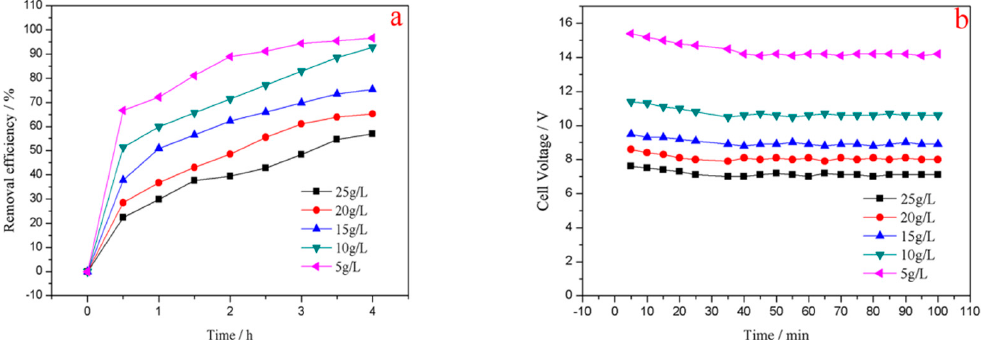
Figure 8. ( a ) Chloride ions removal e ffi ciency under various initial NaCl concentration; ( b ) change in cell voltage under various initial NaCl concentrations. Figure 8. (a) Chloride ions removal efficiency under various initial NaCl concentration; (b) change in cell voltage under various initial NaCl concentrations.